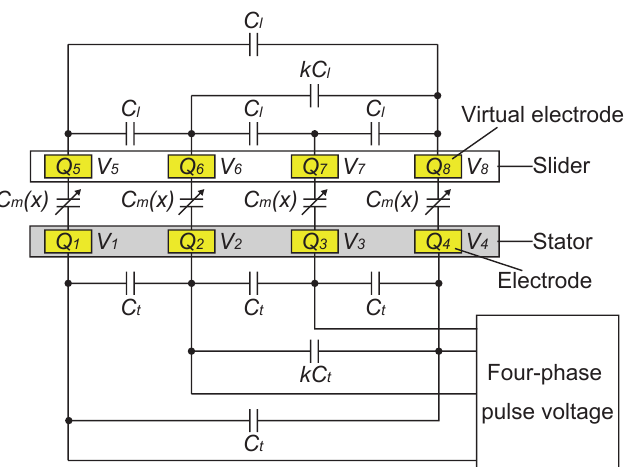
Figure 4. Analysis model of the electrostatic actuator. The model represents one cycle (four electrode pitches) of the structural repetition of the actuator. Although capacitance exists between any two electrodes, some of them are omitted to avoid crowding the